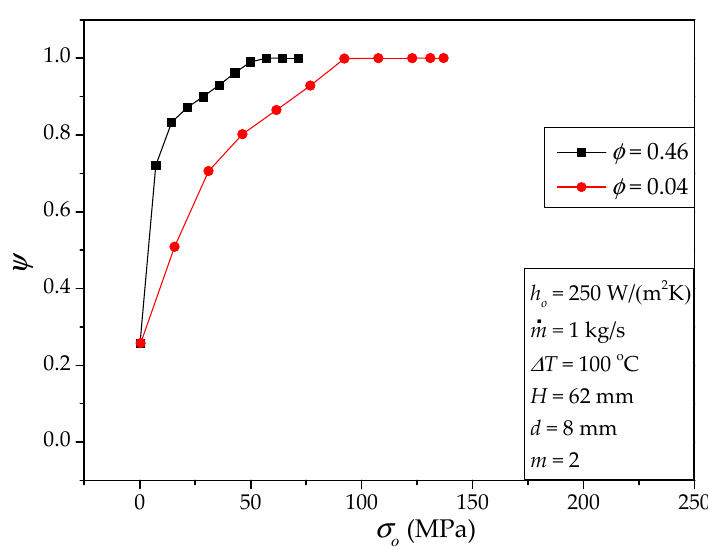
ff erent fluid volume ratio φ .